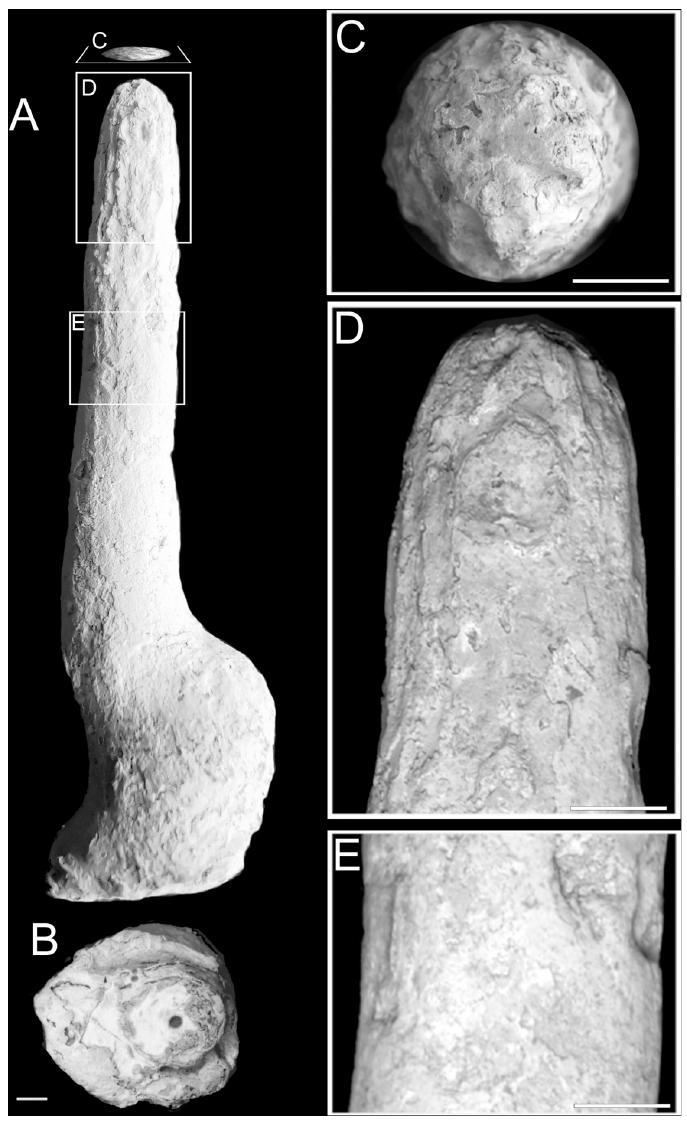
Fig 3. Oligophylloides sp.—Juvenile specimen UAM/He/B/022 with well-preserved growing tip. A, B–external view (side and bottom respectively). Scale bar 2 mm. C–SEM of apical part (top view) of the growing tip; D–SEM of side view of the growing tip with ribs (parasepta) and furrows (interparaseptal) sectors (heterotheca); E–SEM of side view of the smooth protoheterotheca. Scale bars for C, D, E 1 mm.